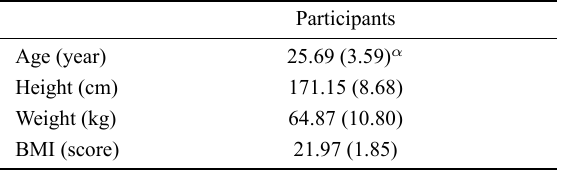
Table 1. General characteristics of participants (N = 20). Participants